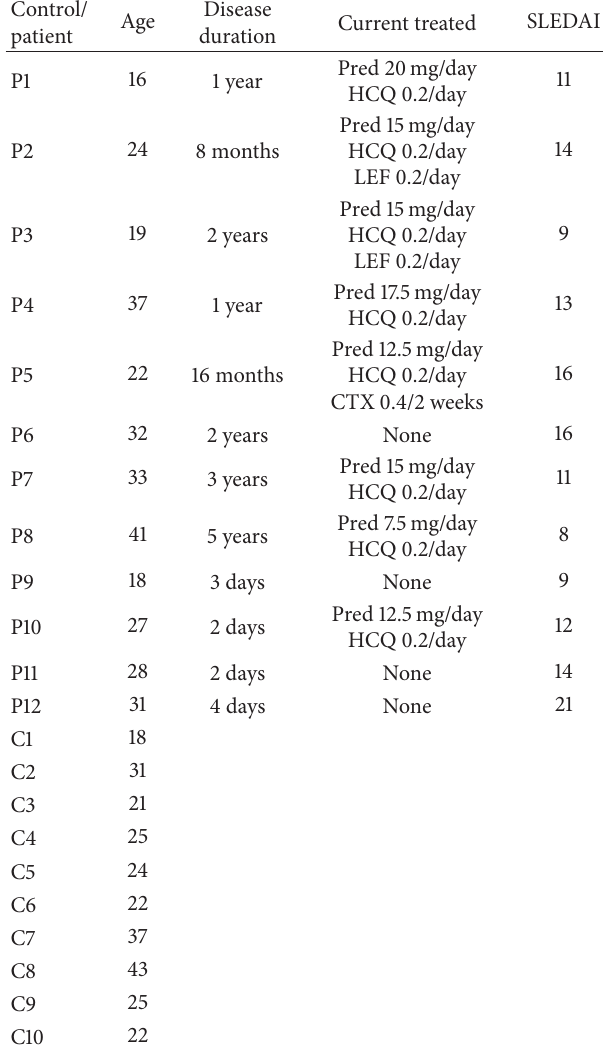
Table 1: Details of 10 controls and 12 SLE